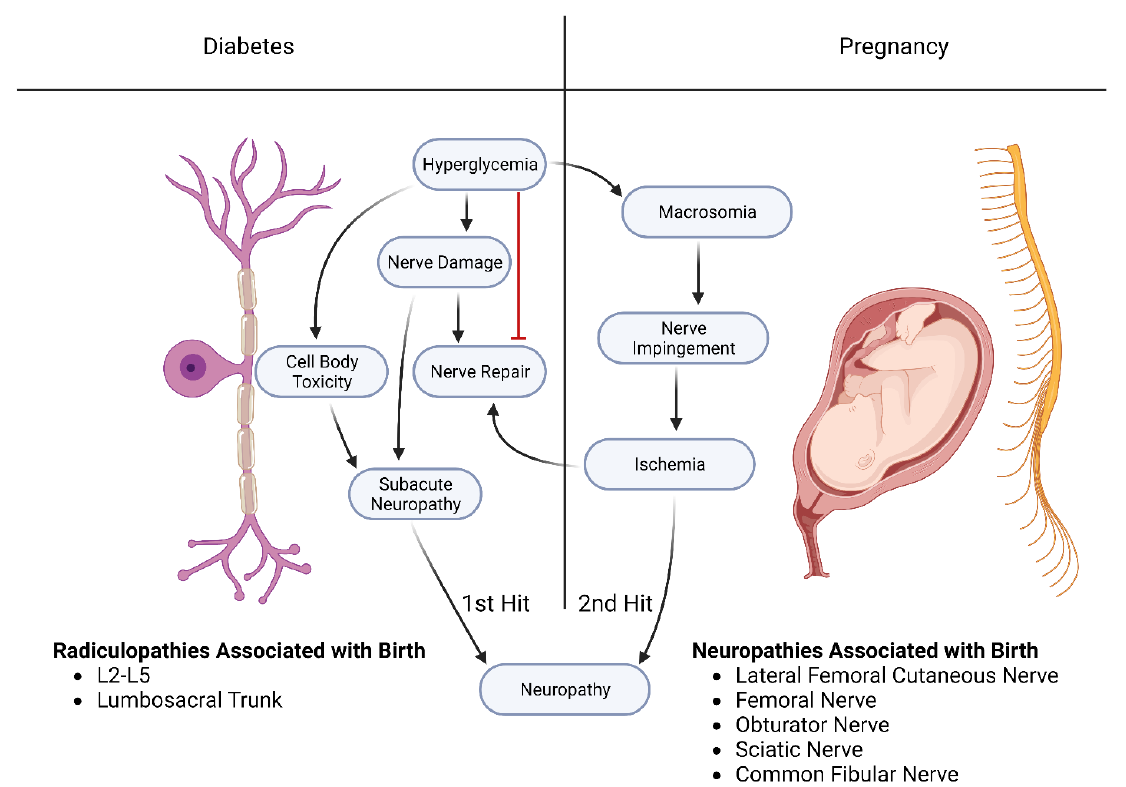
Figure 3. Two-hit hypothesis of diabetic neuropathy in pregnancy: The first hit is believed to be caused by the pathways previously discussed, leading to cell body toxicity and nerve damage. This damage may lead to subacute neuropathy with few symptoms. Diabetes is a common cause of macrosomia, which increases the risk of compression neuropathies during vaginal birth. This compression damage, combined with impaired nerve repair pathways, leads to the second hit, causing the more frequent or severe radiculopathies and neuropathies seen in vaginal births with diabetic mothers.